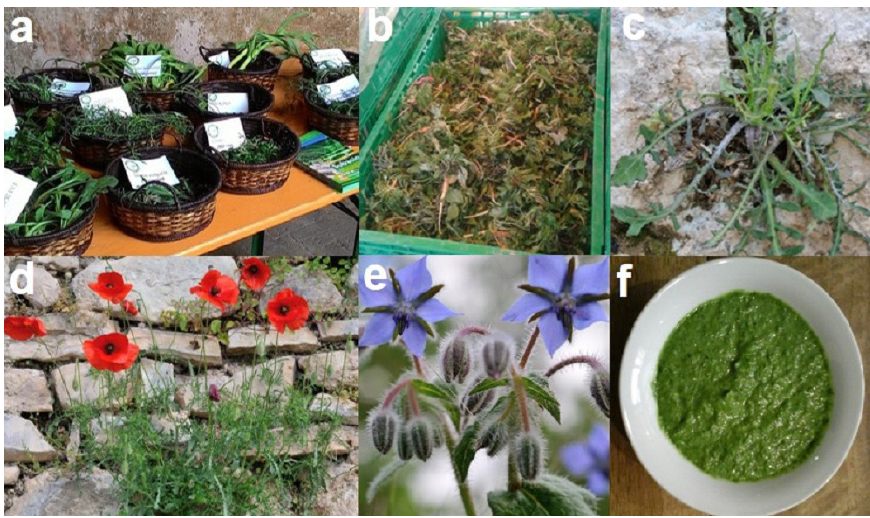
Fig. 2: Exhibition of wild plants: field work to collect and identify wild plants, Spello, during the ‘Subasio con gusto’ event (a); wild edible plants on sale in a local market: ‘raponzoli’ ( Campanula rapunculus L.) (b); common edible wild plants in the Umbria region, for example ‘caccialepre’ [ Reichardia picroides (L.) Roth] (c), ‘papavero’ ( Papaver rhoeas L.) (d) and ‘borragine’ ( Borago officinalis L.) (e); pesto made with wild edible greens